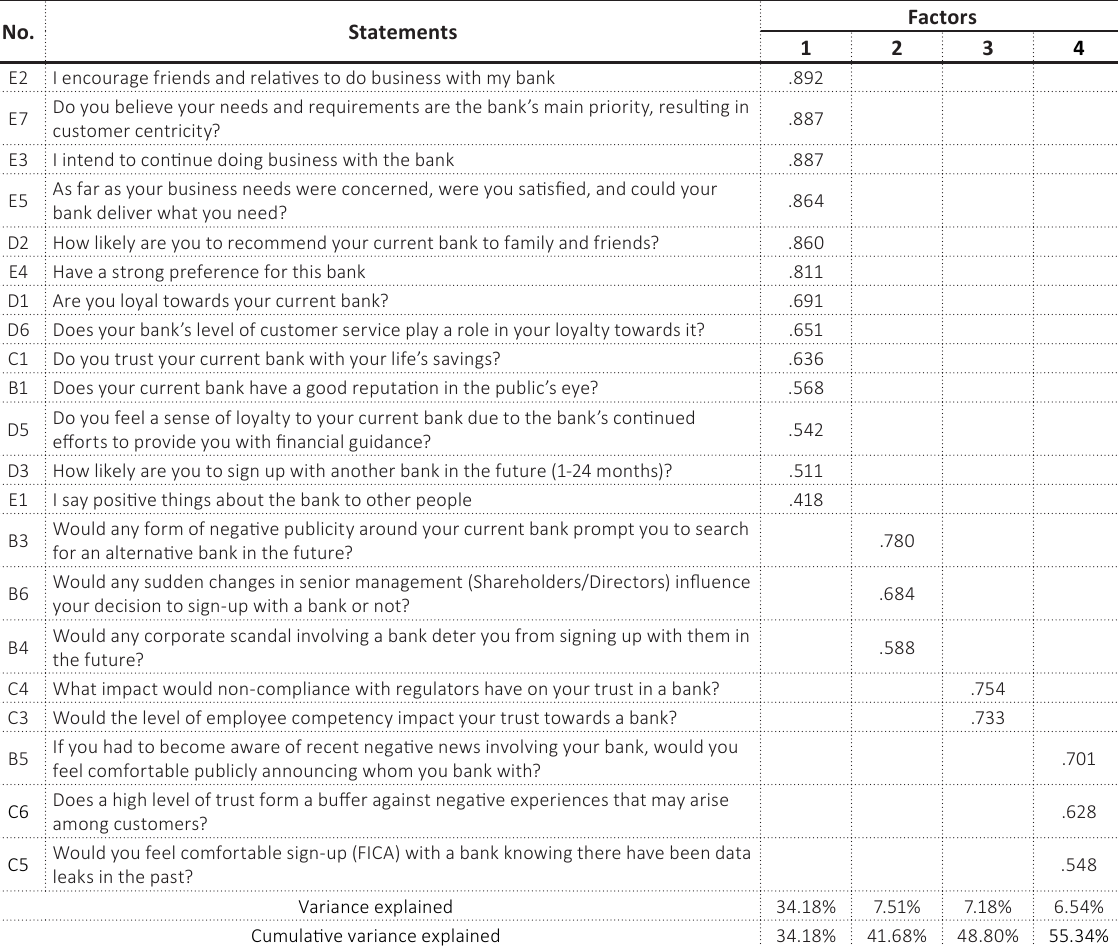
Table 3. Exploratory factor analysis